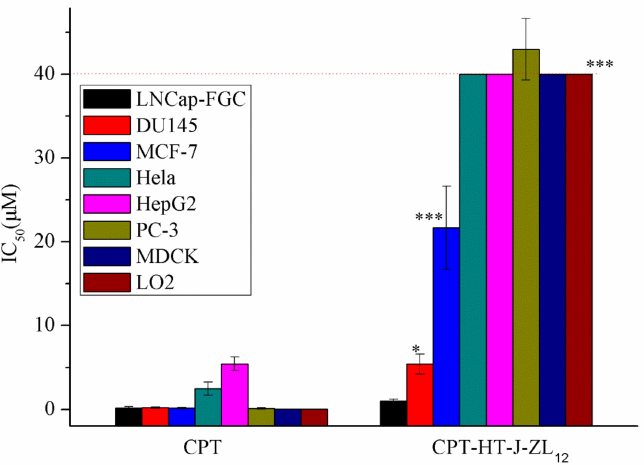
Figure 2. The IC 50 values of CPT and the prodrug CPT-HT-J-ZL 12 on different cell lines. * p < 0.05, *** p < 0.001, vs. LNCaP-FGC